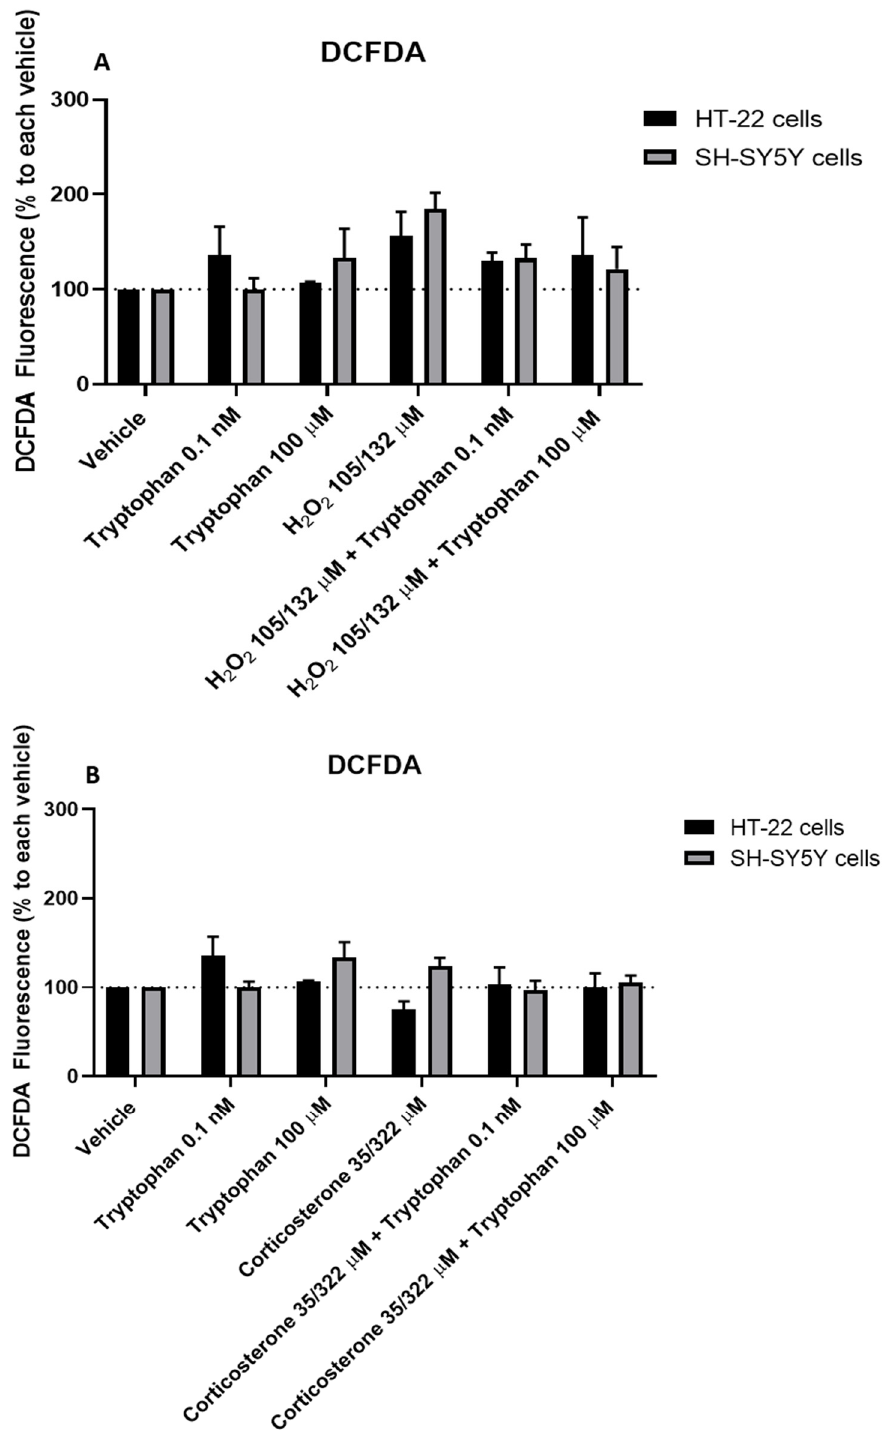
Figure 22. Comparison of SH-SY5Y and HT-22 cells regarding ROS production, for 48 h incubation of ( A ) 105/132 µ M of H 2 O 2 , 0.1 nM/100 µ M of L-tryptophan and 105/132 µ M of H 2 O 2 + 0.1 nM/100 µ M of L-tryptophan (HT-22 and SH-SY5Y cells, respectively) and ( B ) 35/322 µ M of corticosterone, 0.1 nM/100 µ M of L-tryptophan and 35/322 µ M of corticosterone + 0.1 nM/100 µ M of L-tryptophan (HT-22 and SH-SY5Y cells, respectively), determined by DCFDA assay. The results represent the mean ± SEM of 2–6 independent experiments, expressed as the percentage of each vehicle